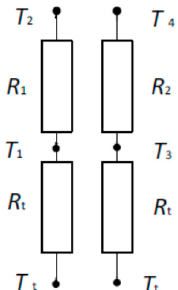
Figure 2. Equivalent resistance circuit of two heat-flow channels. T t —deep tissue layer temperature; T 1 —sensor 1 temperature; T 2 —sensor 2 temperature; T 3 —sensor 3 temperature; T 4 —sensor 4 temperature; R t —tissue thermal resistance; R 1 —thermal resistance of one thermal channel; and R 2 —thermal resistance of another thermal channel.